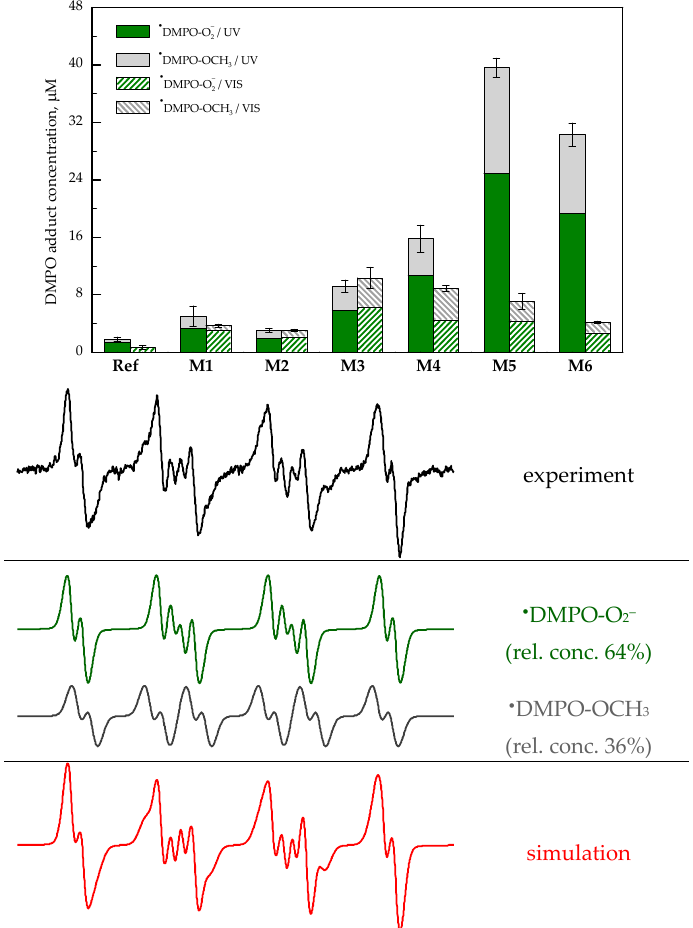
Figure 6. The concentration of DMPO spin-adducts evaluated from the EPR spectra obtained in the aerated DMSO suspension of M1–M6 and P25 photocatalysts, along with reference (photocatalyst-free solution) in the presence of the DMPO spin trap upon 180-s UV exposure ( λ max = 365 nm; irradiance 15 mW cm –2 ) or 480-s visible (160 klx) light. Experimental EPR spectrum (magnetic field sweep of 5 mT) measured in the aerated DMSO suspension of M5 in the presence of DMPO upon VIS-light Initial concentrations: c (photocatalyst) = 0.33 g L –1 , c 0 (DMPO) = 0.035 M.